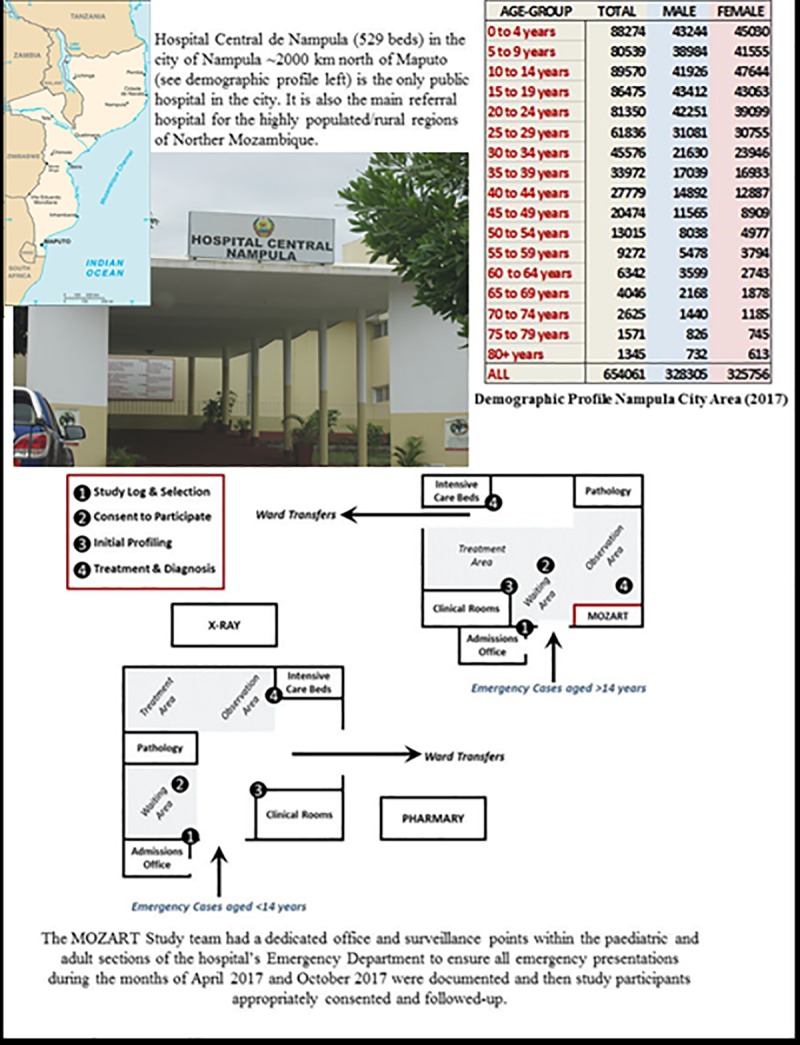
Hospital Central de Nampula (529 beds) in Nampula (Northern Mozambique).Public domain map of Mozambique sourced from: https://www.drivingdirectionsandmaps.com/mozambique-google-map/ (Accessed May 2019).